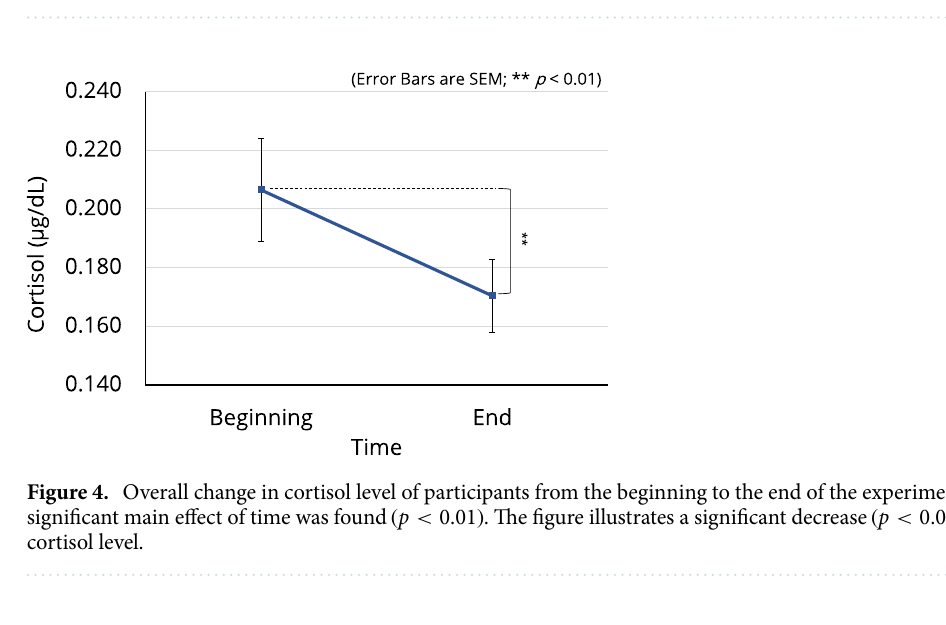
Figure 3. Salivary oxytocin levels of participants in the three conditions. A trend decrease (p = 0.051) in oxytocin level was observed when participants in condition C3 were WR compared with when they were NWR.